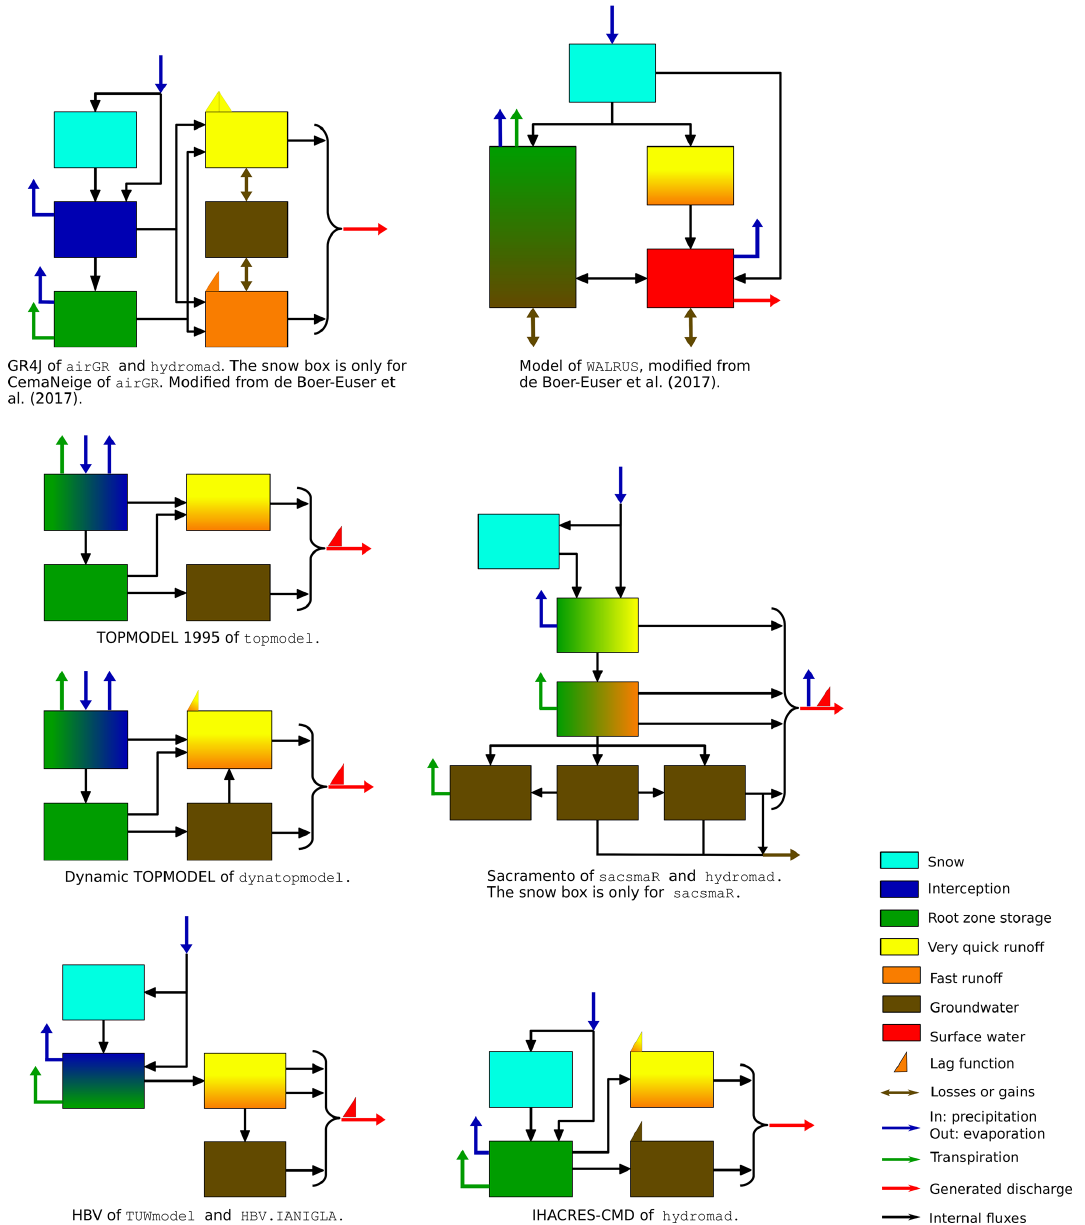
Figure 1. Unified diagrams illustrating the depiction of conceptual storages and fluxes by the main models contained in the selected